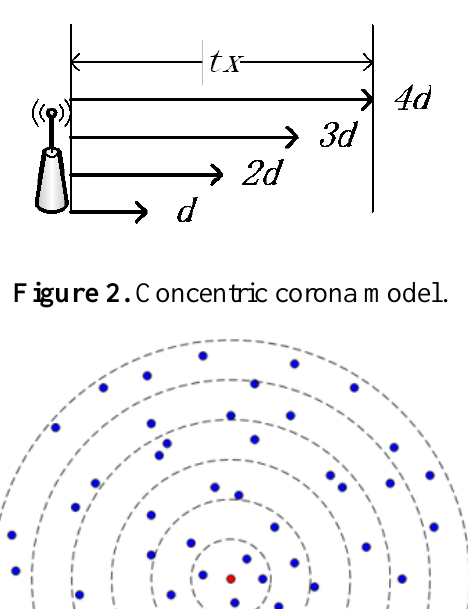
Figure 1. The adjustable transmission range.